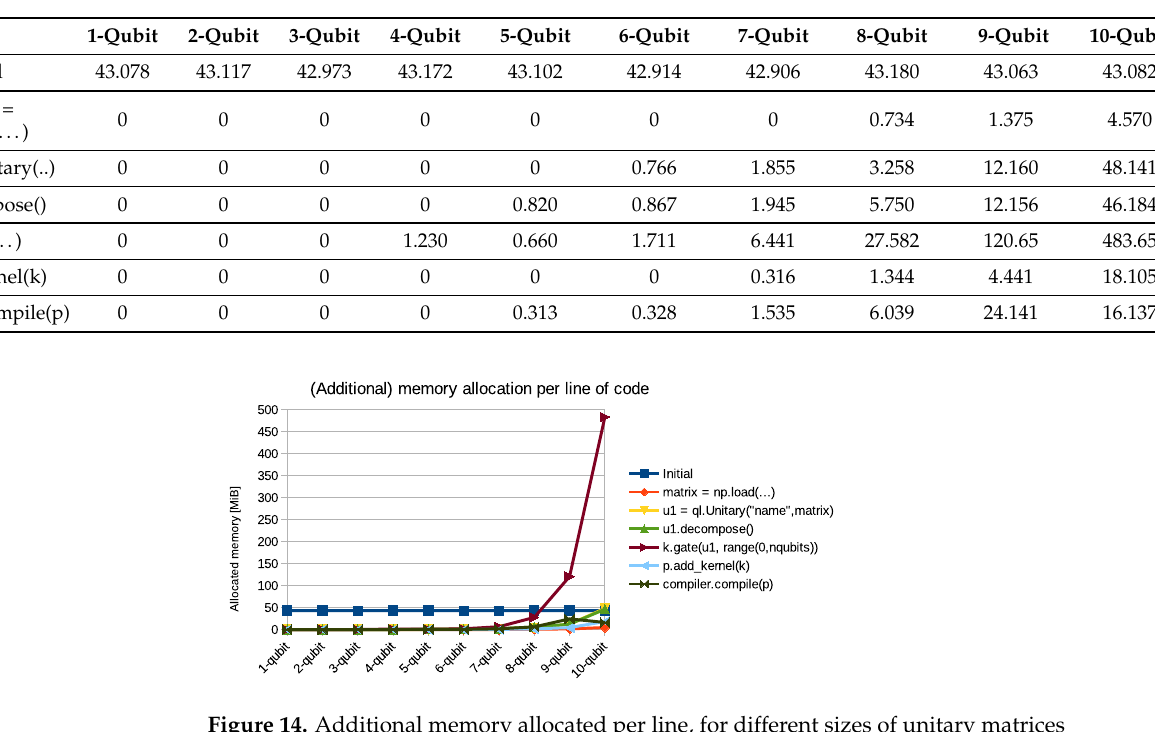
Table 3. Additional memory allocated at each line of Listing 1 for the decomposition of unitary matrices of different sizes, in MiB.